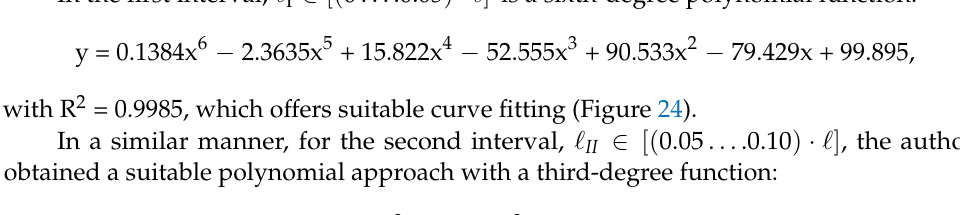
Figure 24. The relative m ψ [ % ] vs. (cid:96) [ % ] along the first interval, (cid:96) I ∈ [( 0 . . . .0.05 ) · (cid:96) ] . In the first interval, (cid:96) I ∈ [( 0 . . . .0.05 ) · (cid:96) ] is a sixth-degree polynomial